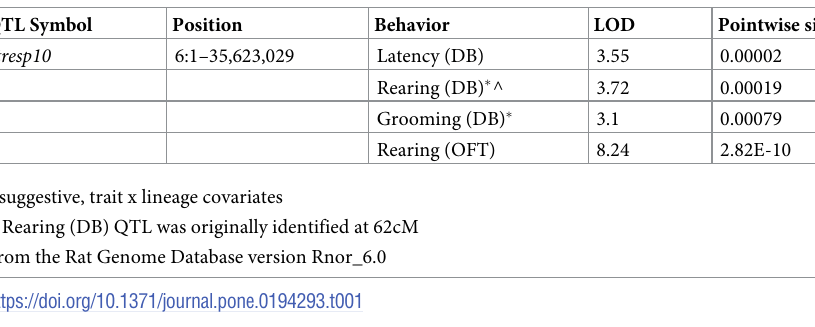
Table 1. List of behavioral phenotypes associated with the Stresp10